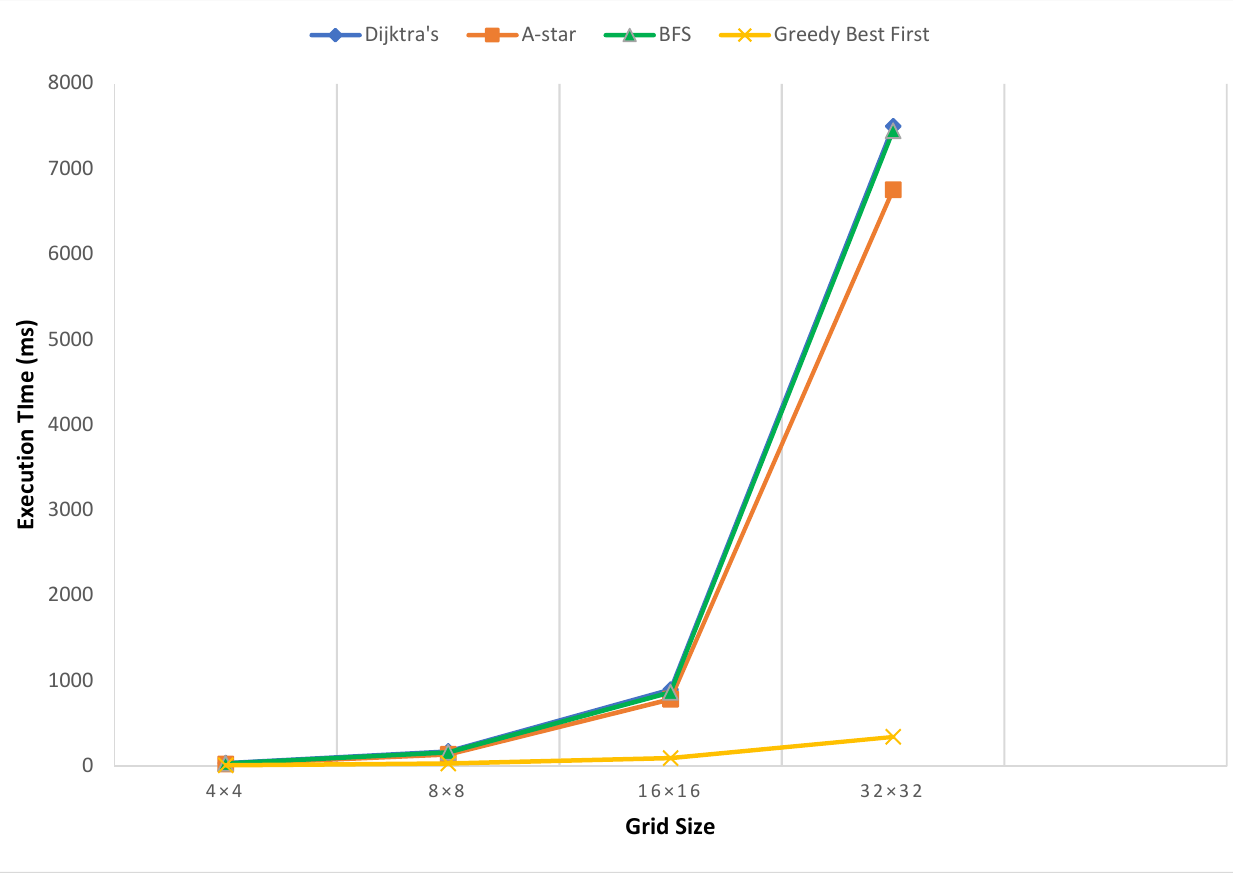
Figure 15. Graphical representation of pathfinding Algorithms without obstacles.